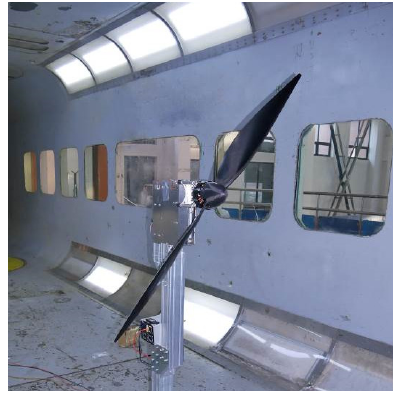
Figure 13. Propeller wind tunnel test.